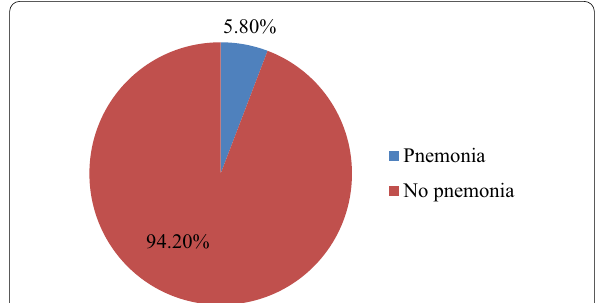
Fig. 1 Prevalence of pneumonia among 6–59 months children in Angolalla Tera district